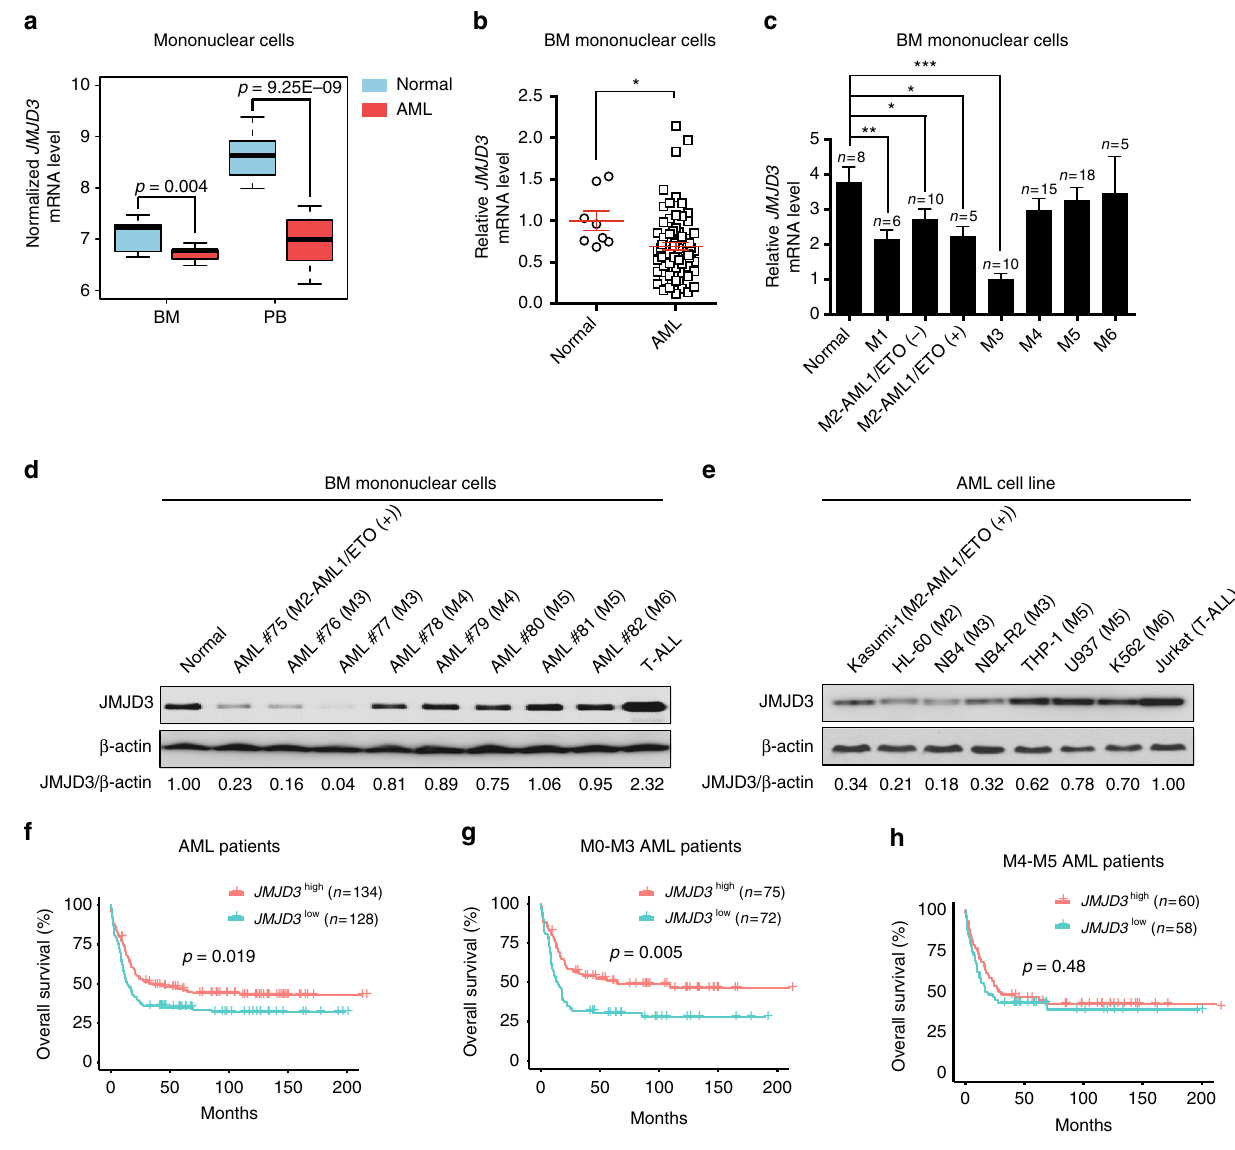
Fig. 1 JMJD3 expressional reduction is correlated with poor prognosis in certain subtypes of AML cases. a JMJD3 mRNA levels in BM and PB mononuclear cells of AML patients (including seven BM or 19 PB samples) and in normal counterparts (ten BM and ten PB samples) were compared (raw data retrieved from GEO (GSE9476) dataset). Boxes denote interquartile range, with a line at the median, while whiskers are indicating minimal and maximal observations for each parameter. b qRT-PCR assay on the JMJD3 mRNA level in the AML blasts-enriched primary BM mononuclear cells ( n = 74) or normal BM mononuclear cells ( n = 8). c qRT-PCR assay on the JMJD3 mRNA level in the AML blasts-enriched primary BM mononuclear cells including subtype M1 ( n = 6), M2-AML1/ETO ( − ) ( n = 10), M2-AML1/ETO ( + ) ( n = 5), M3 ( n = 10), M4 ( n = 15), M5 ( n = 18), M6 ( n = 5) or normal BM mononuclear cells ( n = 8). d Western blotting assay on JMJD3 protein levels of eight AML blasts-enriched primary BM mononuclear cell samples, a normal BM mononuclear cell sample, and a T-ALL blasts-enriched BM mononuclear cell sample. β -actin level was used as the loading control. e Western blotting assay on JMJD3 protein levels of the established leukemia cell lines. f – h Overall survival of AML patient cohort ( f ), M0, M1, M2, and M3 AML patient cohort ( g ), or M4 and M5 AML patient cohort ( h ) with regard to JMJD3 mRNA levels. Data are shown as the mean ± SEM; * p < 0.05, ** p < 0.01, *** p <